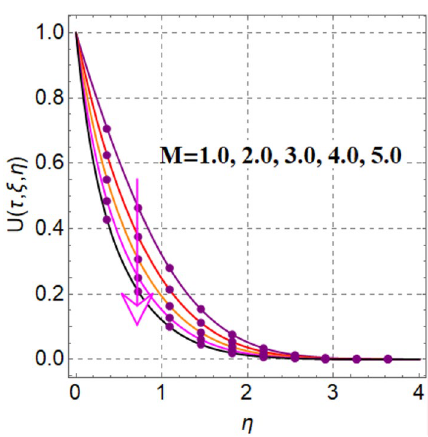
Figure 3. U (τ , ξ , η) via M .